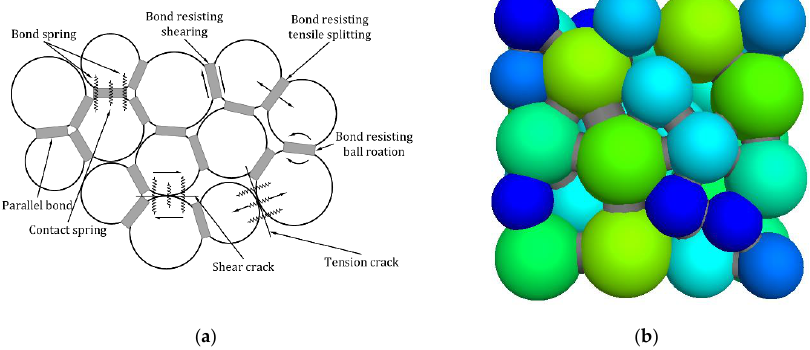
Figure 2. Schematic of particle-based discrete element method (PB-DEM) in ( a ) 2-D and in ( b ) 3-D cases.